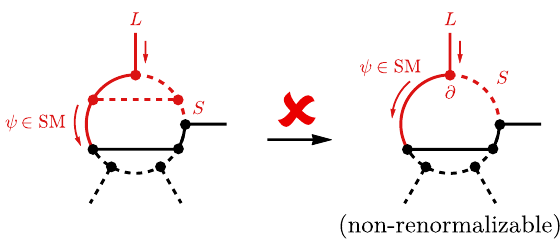
Figure 3 . Example of a diagram with topology 89, containing a one-loop fermion-fermion-scalar e(cid:11)ective interaction (in red). This loop is removable unless is a SM fermion.